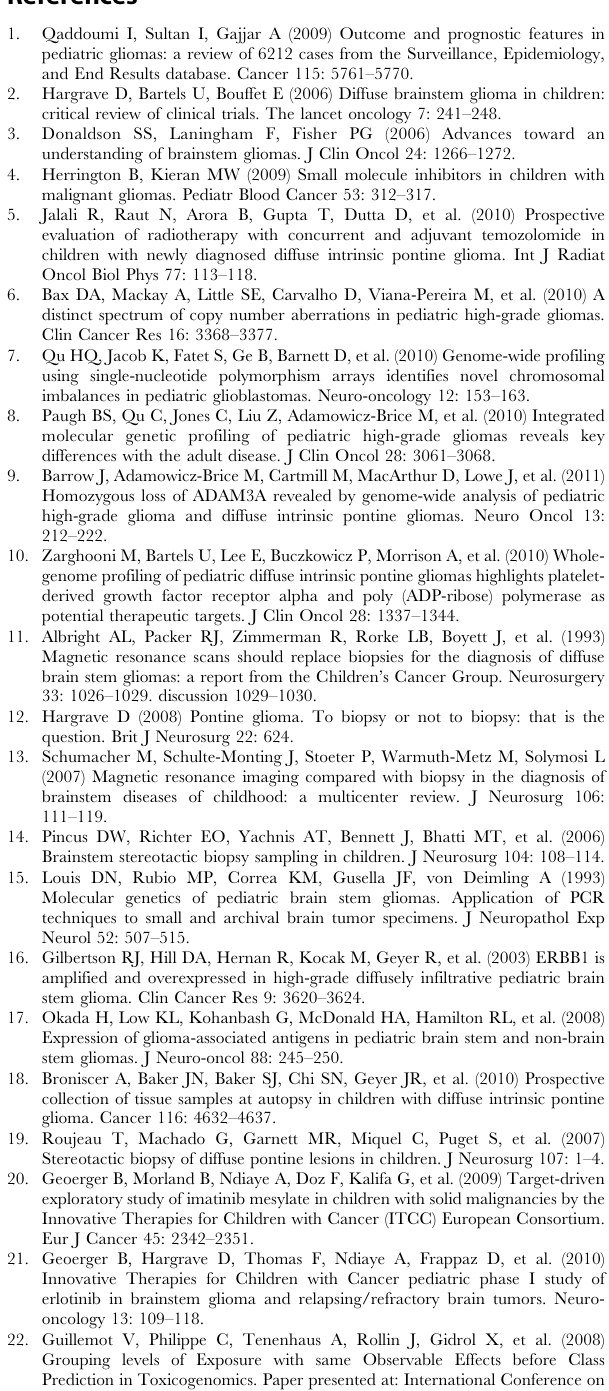
(XLSX) (XLS) (XLS) Supporting Information S1